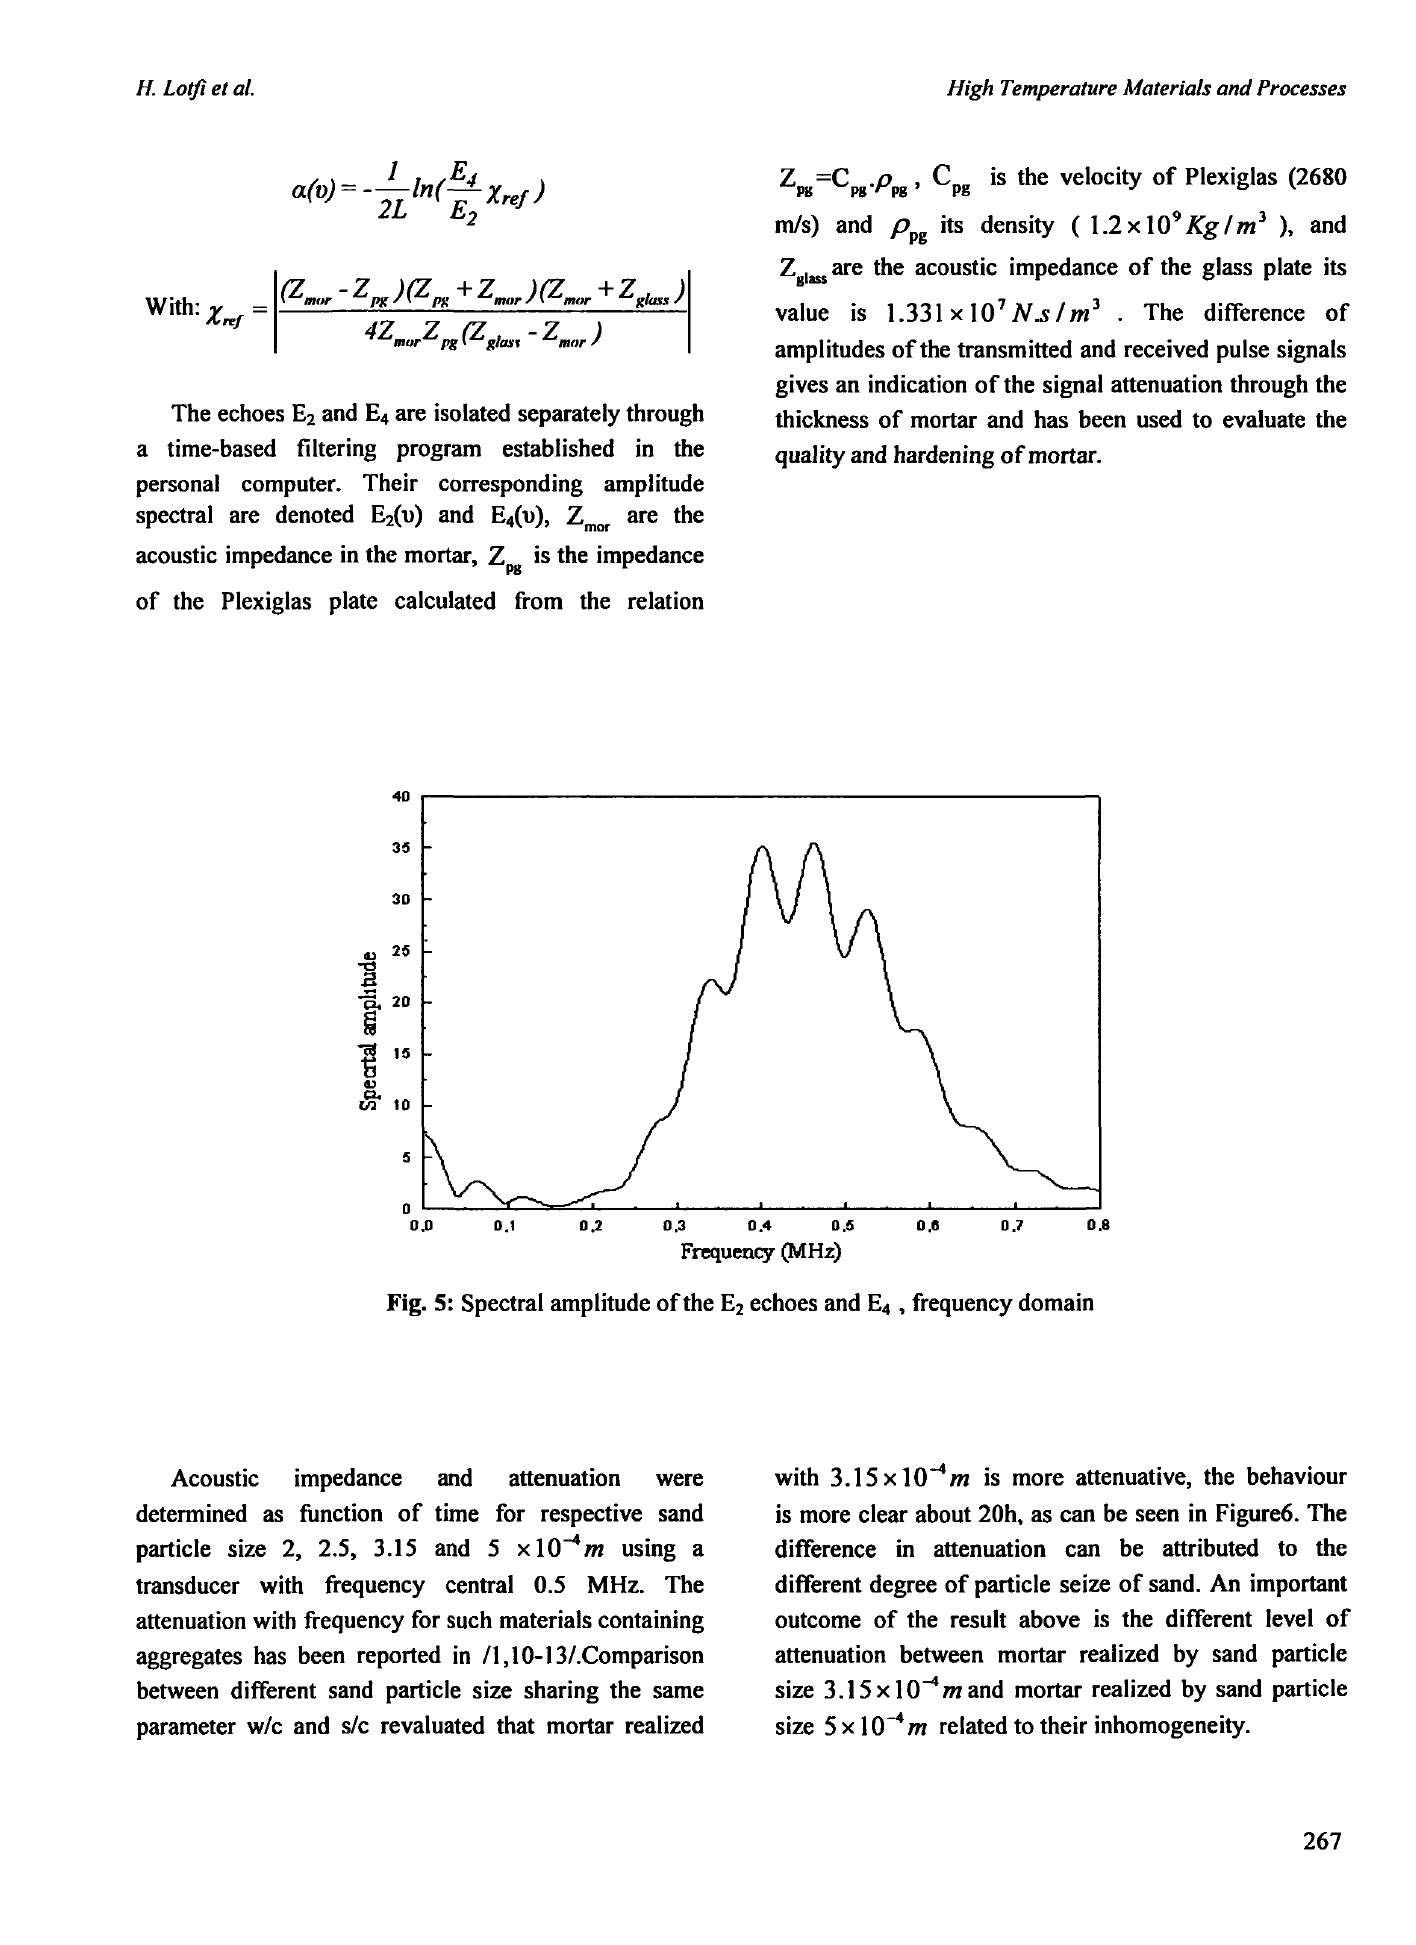
echoes and E , frequency 2 4